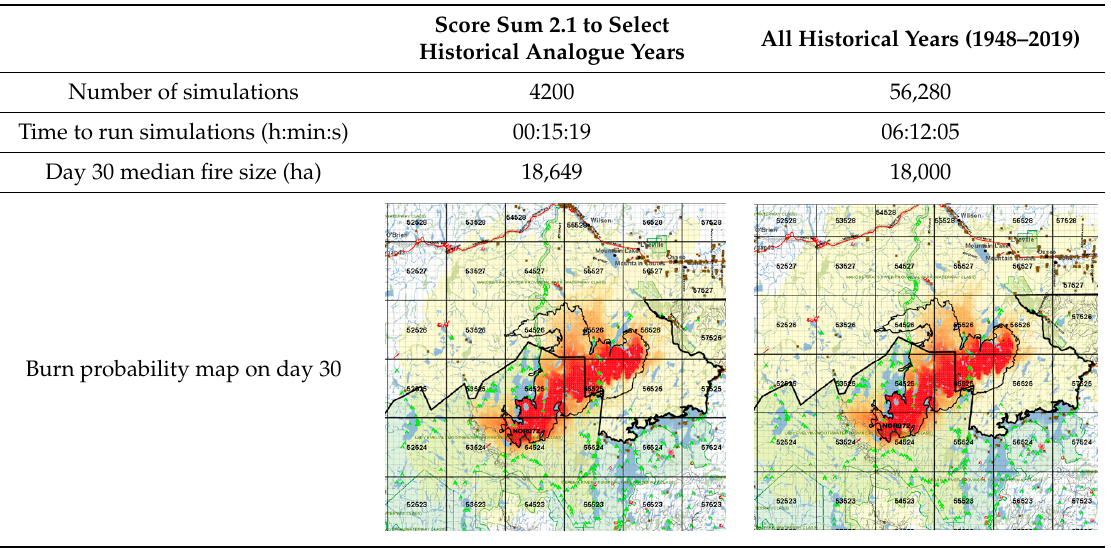
Table 3. Comparison of the computational burden and the burn probability maps when using the historical analogue years vs. all historical years as weather forecast scenarios. The black outline is the actual perimeter of the fire; the red-to-yellow gradient indicates burn probability. Note, fire simulations were initiated from a perimeter (10,396 ha).